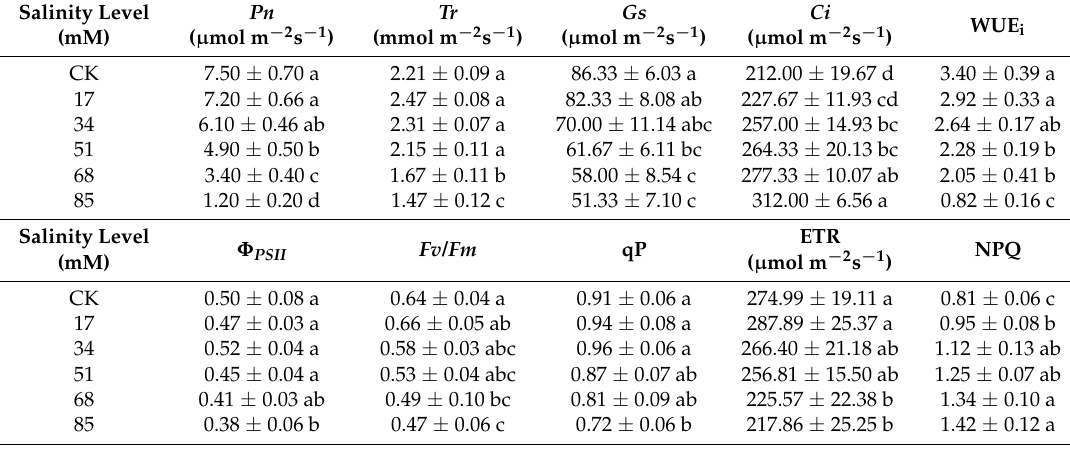
Table 2. Effects of various salinities on photosynthesis and chlorophyll fluorescence parameters in C. turczaninowii after 42 days. Pn , net photosynthetic rate; Tr , transpiration rate; Gs , stomatal conductance; Ci , intercellular CO 2 concentration; WUE i , water use efficiency; Φ PSI I , photochemical quantum efficiency; Fv/Fm , maximum quantum yield of photosystem II; qP, photochemical